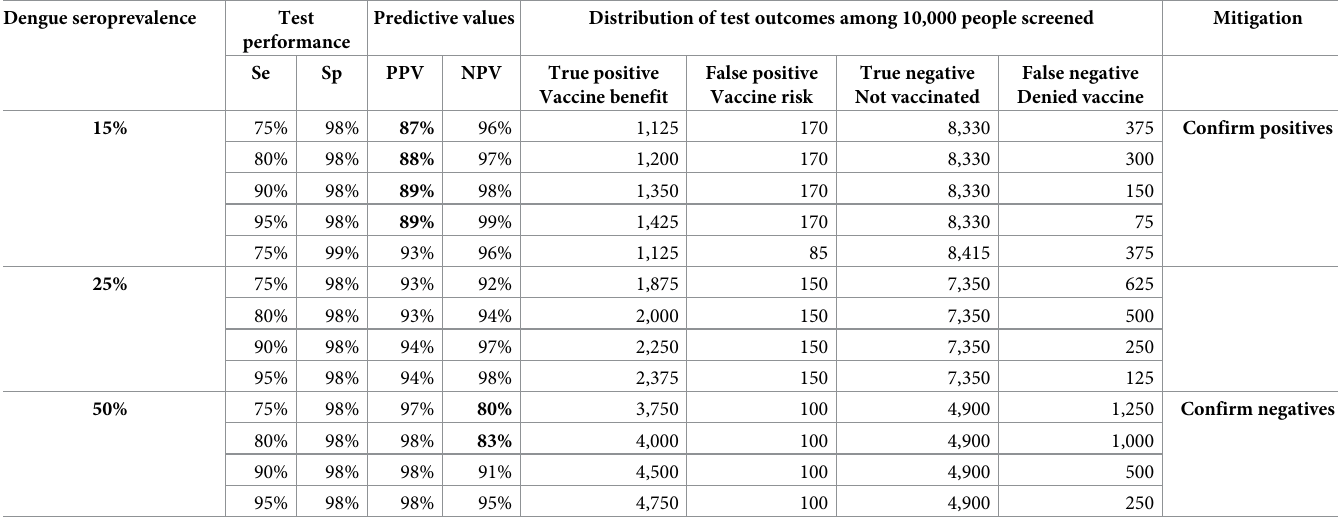
NPV, negative predictive value; PPV, positive predictive value; Se, sensitivity; Sp,